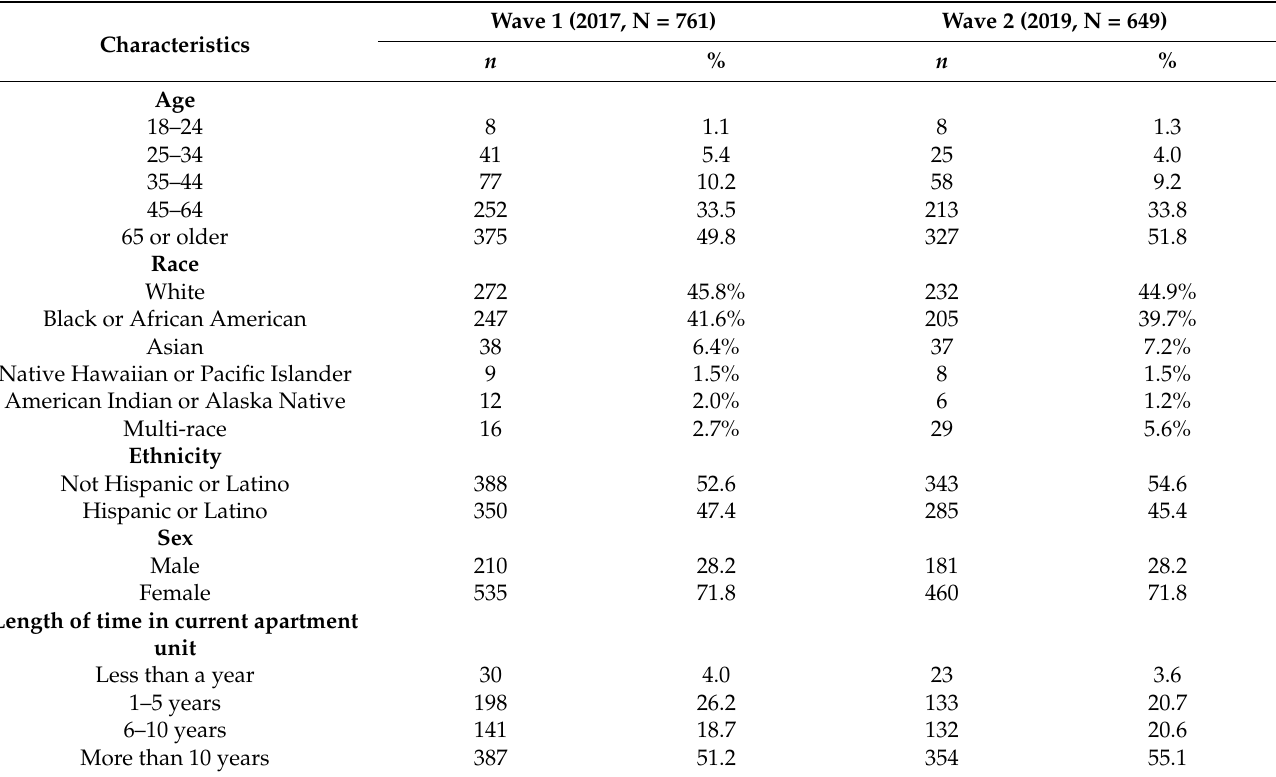
Table 1. Wave 1 and Wave 2 sample